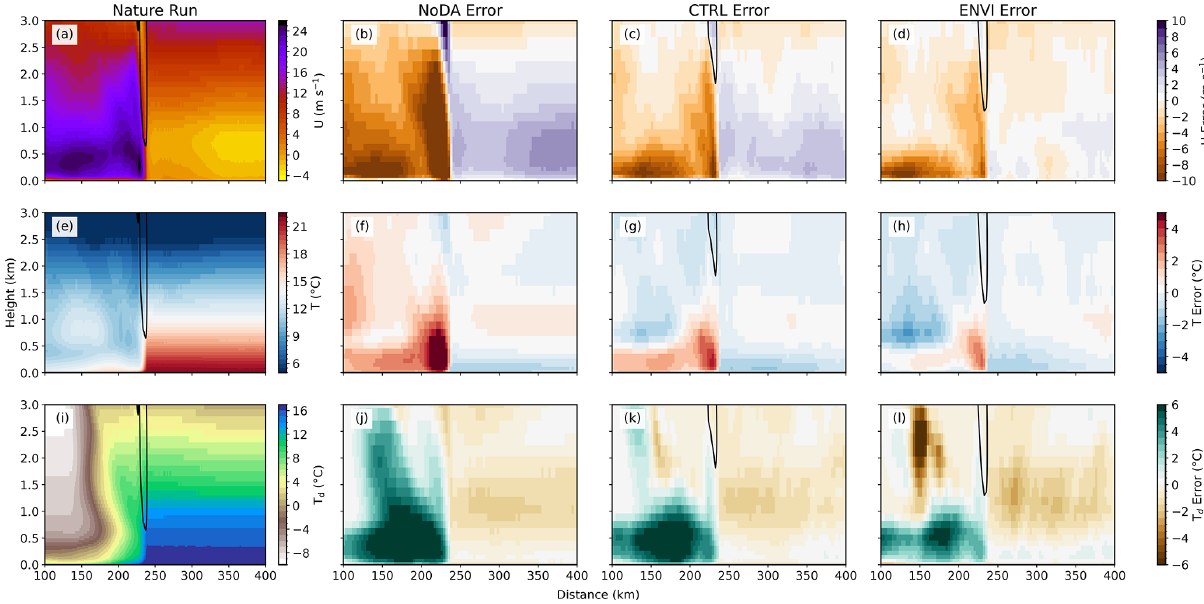
Figure 12. Ensemble mean posterior error at the time of the final data assimilation cycle (02:30UTC) for (b–d) u wind, (f–h) T , and (j–l) T d . Errors are averaged in the north–south direction. Regions where the north–south average updraft velocity exceeds 2.0ms − 1 are contoured.